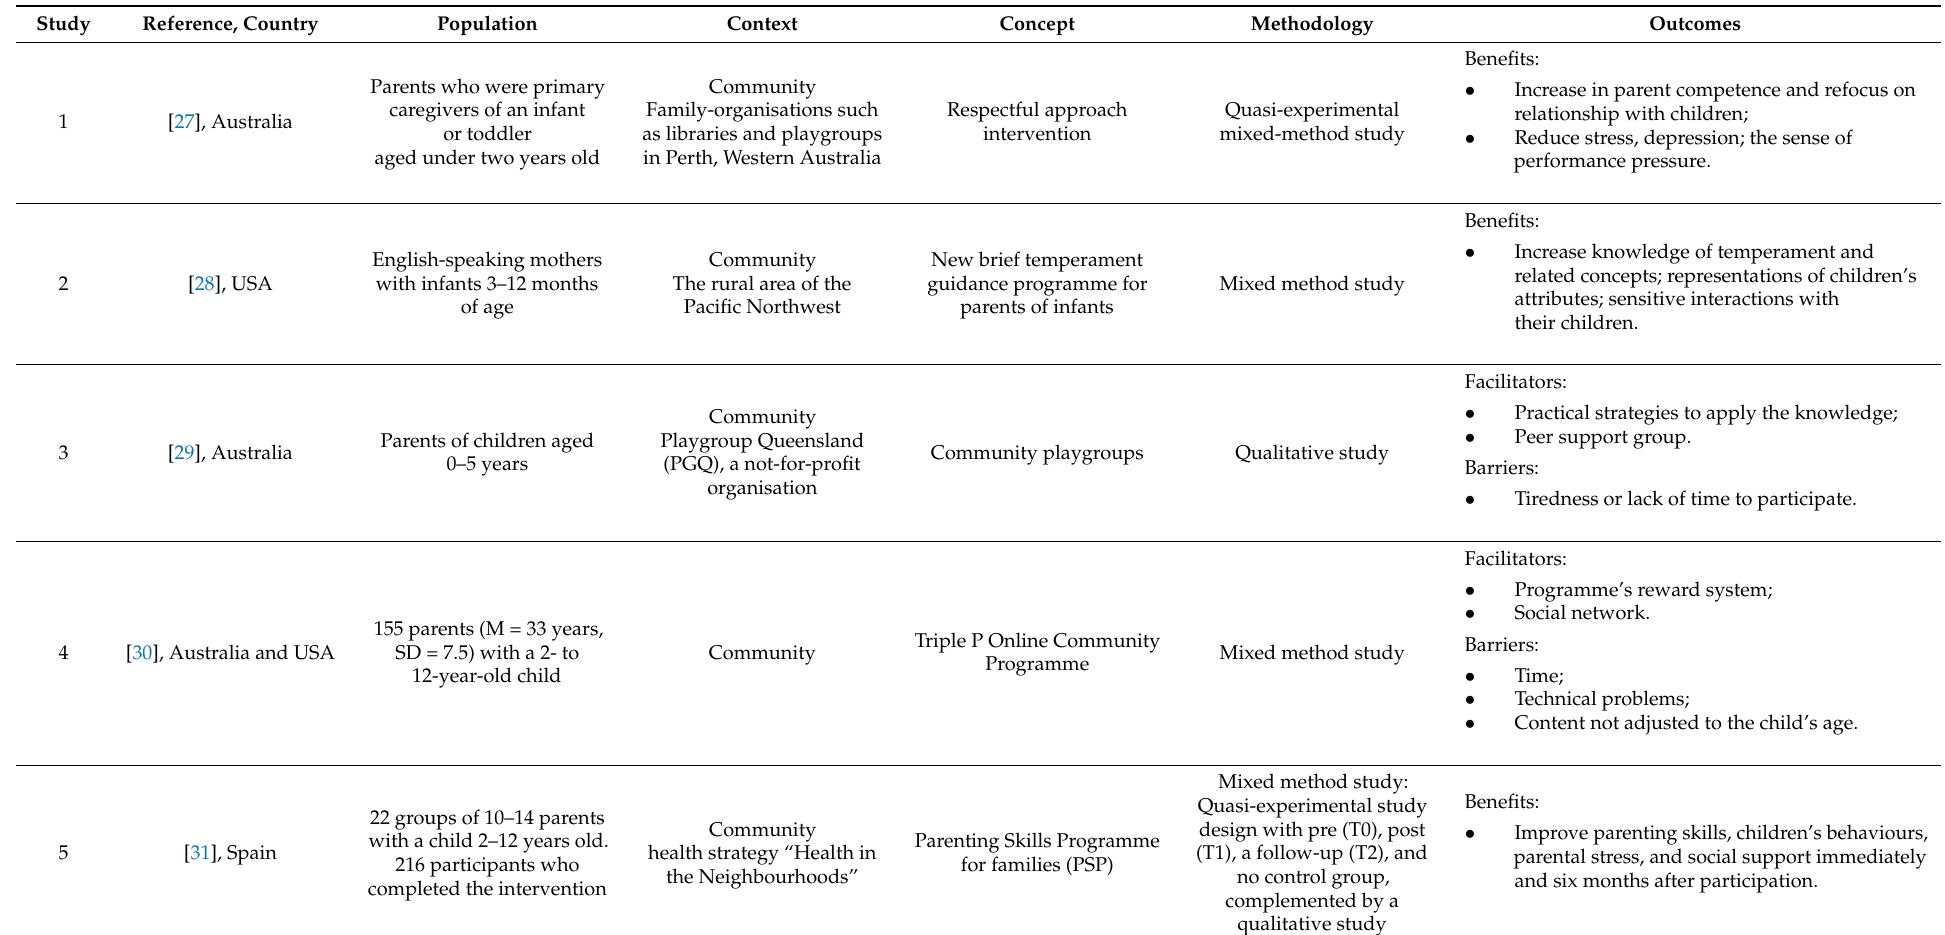
Table 2. Characteristics of the included